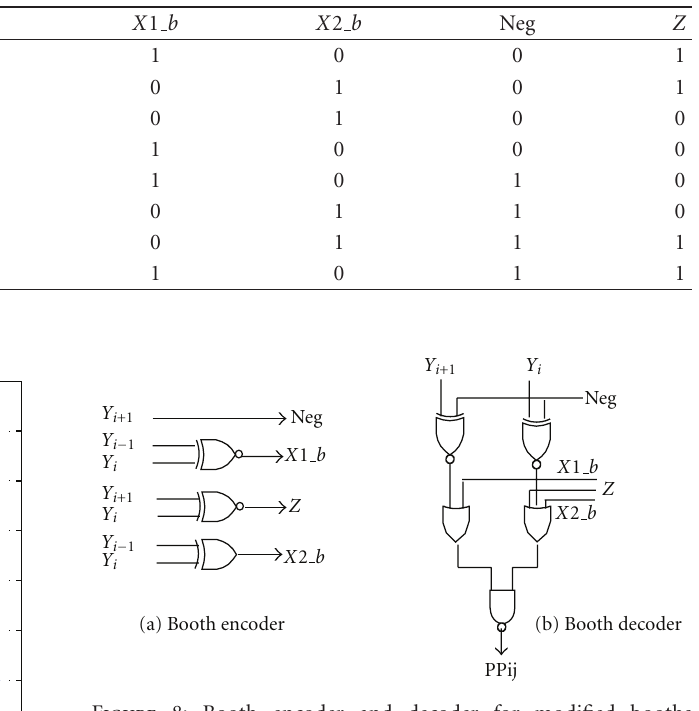
Figure 8: Booth encoder and decoder for modified booths